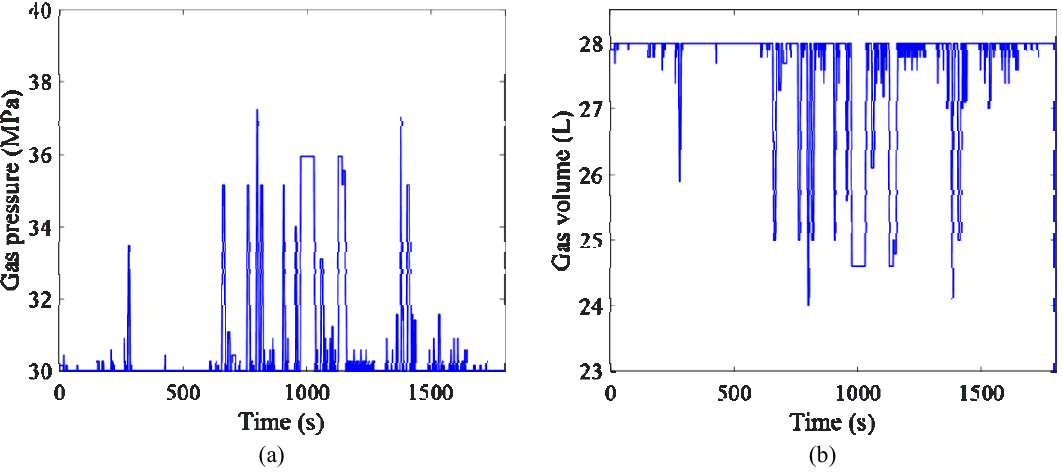
Figure 8. HPA gas pressure and volume change during WLTP-3.